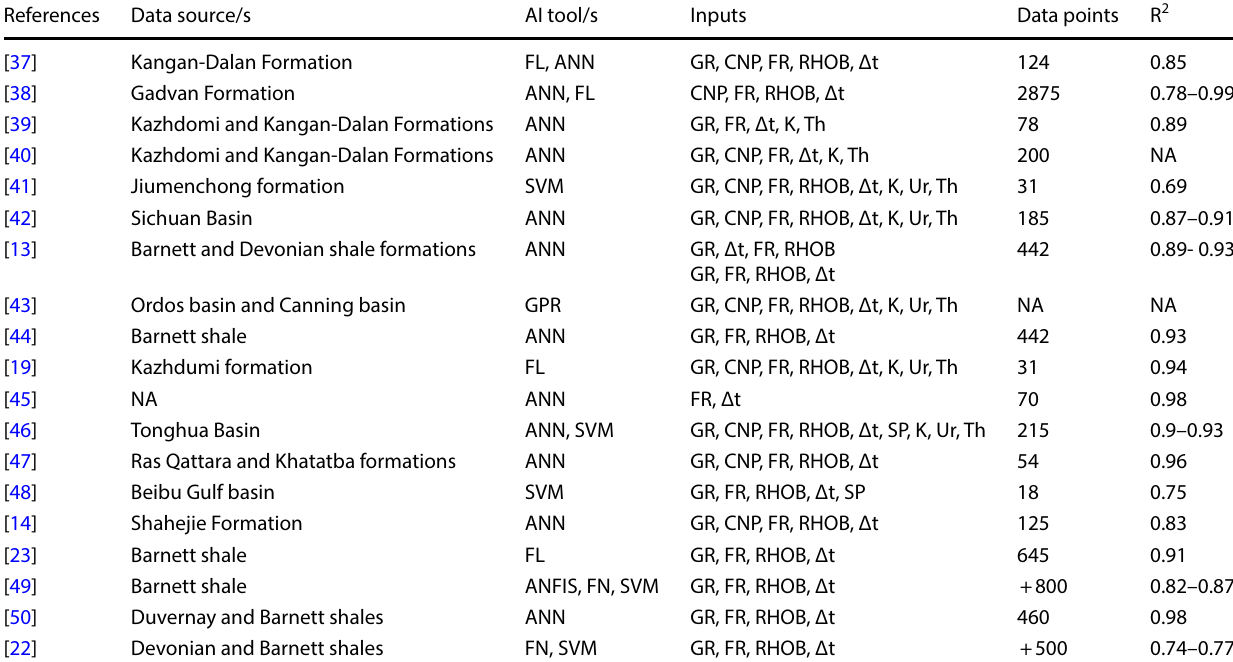
Table 2 Different researches that utilize AI techniques in TOC